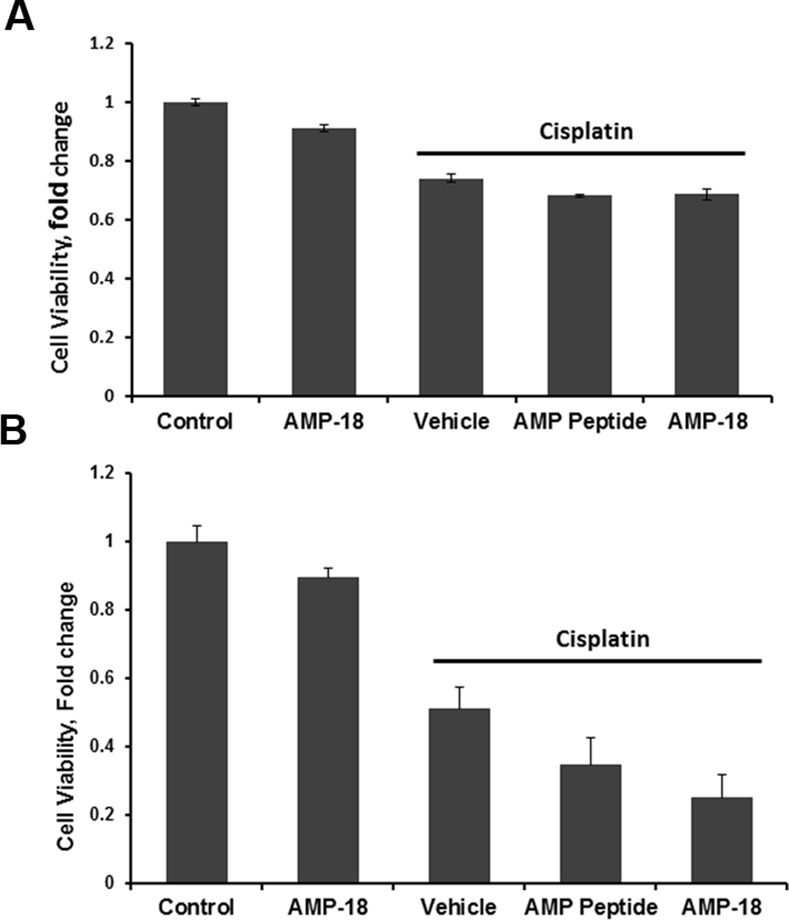
Inhibitory effects of AMP peptide and AMP-18 on HNC cells.SCC-25 (A) or SCC-61 (B) cells were left untreated, exposed to AMP-18 (2 μg/ml), cisplatin (2 μM for SCC-25 cells, 10 μM for SCC-61 cells) only, cisplatin in the presence of 2 μg/ml AMP peptide, or rhAMP-18 for 48 h. Cell viability was assayed by CellTiter-Blue reagent. Experiments were performed in quadruplicate. Values are mean ± SE. Adding either AMP peptide or rhAMP-18 amplified the cytotoxicity of cisplatin by inhibiting growth of SCC-25 cells by >30% (AMP peptide, P = 0.013; rhAMP-18, P = 0.03), and SCC-61 cells by 65% (P<0.05) and 75% (P<0.02), respectively.